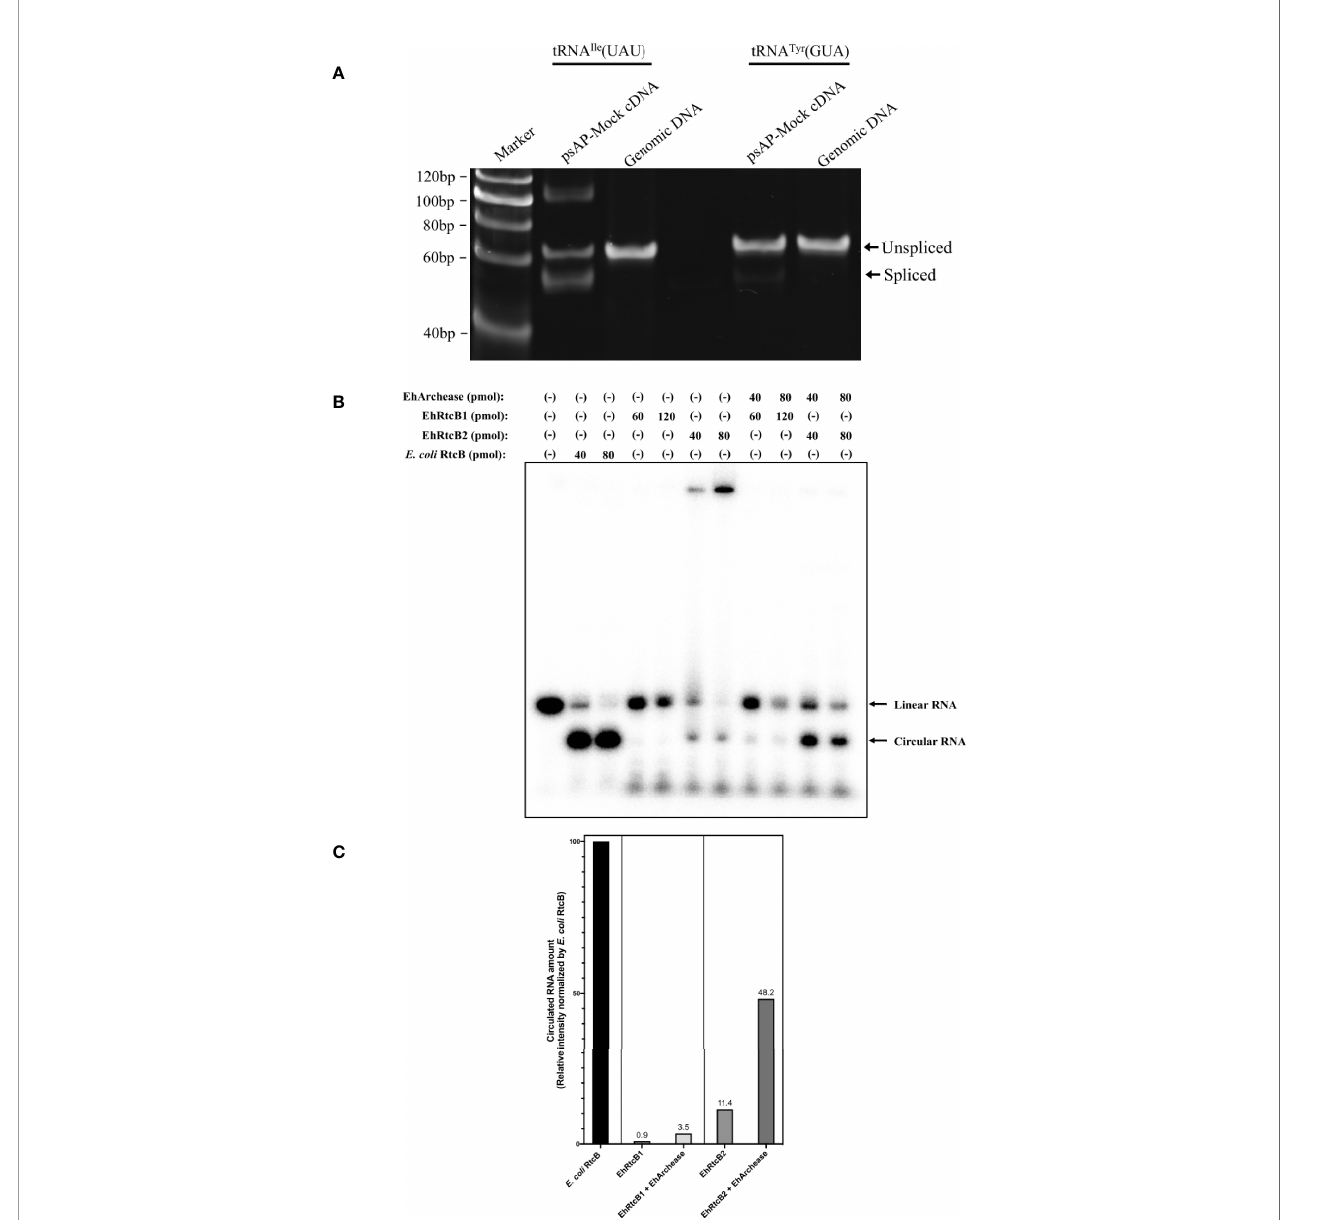
FIGURE 2 | Veri fi cation of in vivo and in vitro EhRtcBs activity. (A) Veri fi cation of in vivo tRNA splicing of tRNA Ile (UAU) and tRNA Tyr (GUA) by RT-PCR. The tRNA splicing was examined by RT-PCR with common forward and reverse primers and polyacrylamide gel electrophoresis, by which both unspliced and spliced cDNAs from tRNA transcripts and genomic fragments were detected. RT-PCR with RNA samples without reverse transcriptase reaction failed to amplify corresponding bands in the same conditions (see Figure 3B ). (B) Veri fi cation of in vitro RNA ligase activity by recombinant EhRtcBs. The assay mixture contained EhRtcB1, EhRtcB2, or E. coli RtcB in the presence or absence of EhArchease. RNA ligase activity of EhRtcBs and E . coli RtcB was monitored using 32 P-labeled RNA substrate by RNA self-ligation assay. Linear and circular RNA are indicated. (C) Quantitation of circularized RNA. The intensity of the circularized RNA was measured by densitometric scanning of the gel image. The intensities of the bands corresponding to circularized RNA produced by EhRtcB1, EhRtcB2 only, EhRtcB1 plus EhArchease, or EhRtcB2 plus EhArchease are shown relative to that produced by E . coli RtcB. The normalized levels of circularized RNA are shown on each bar. Note that the ligase activity of EhRtcB1/2 was increased by EhArchease: relative EhRtcB1 and EhRtcB2 ligase activity (normalized against E . coli RtcB) were 11.4 and 48.2%, respectively, which were increased by 2.89 and 12.8-fold, respectively, compared to that without